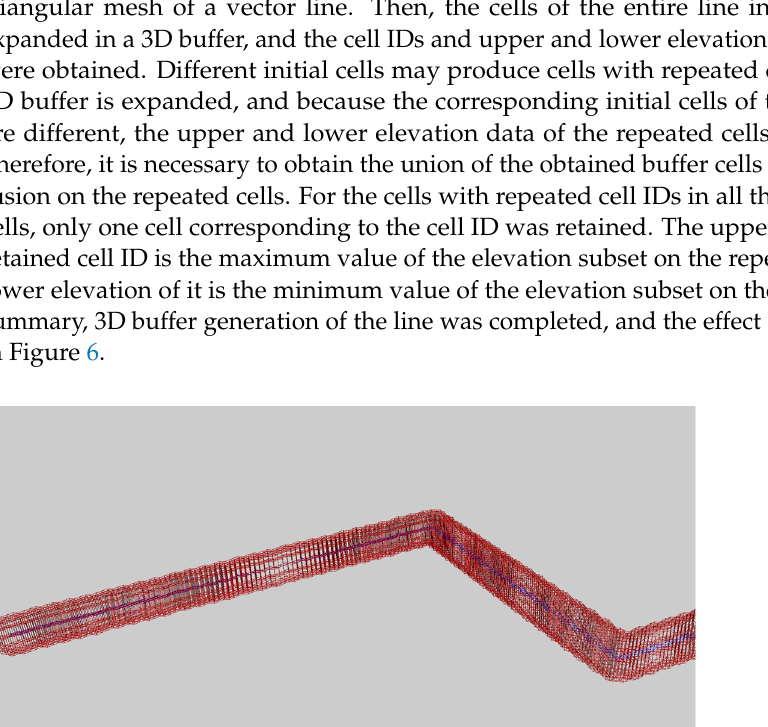
Figure 5. ( a ) The spherical 2D buffer of a point; ( b ) The sphere 3D buffer of a point.